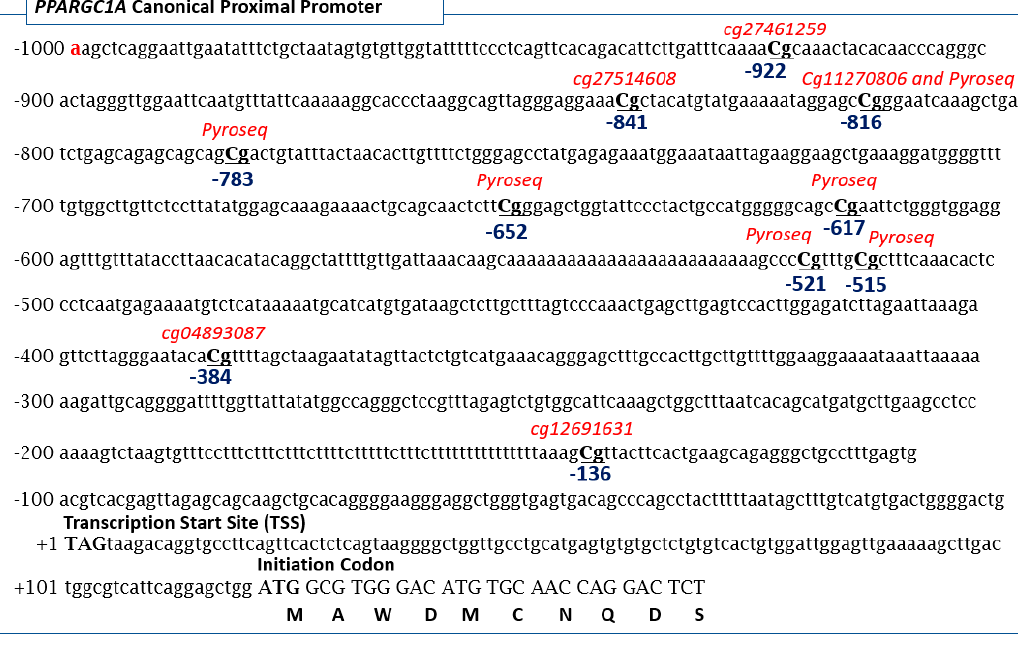
Figure 1. CpG sites in the PPARGC1A gene promoter assessed in this study.